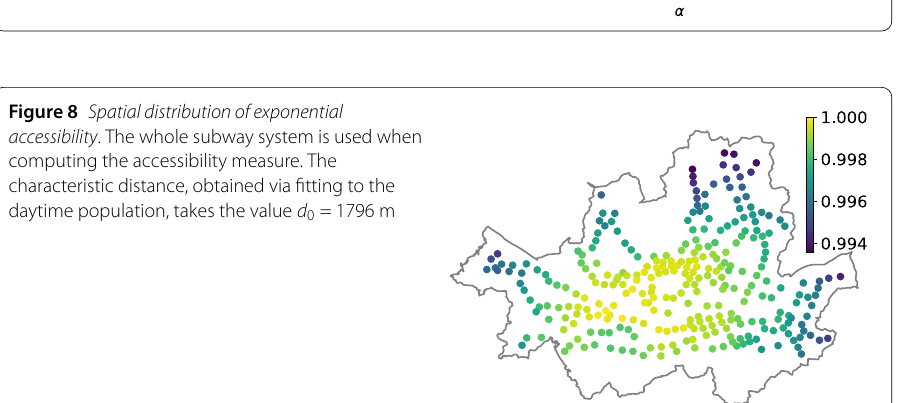
Figure 7 Pearsoncorrelationsbetweenaccessibility measures . Each cell color represents the Pearson correlation coefficient between exponential accessibility and algebraic accessibility given by Eq. (3) together with Eq. (4), with parameters d 0 and α , respectively. The values that colors represent are given in the color bar: brighter colors indicate higher correlations between the two accessibilities